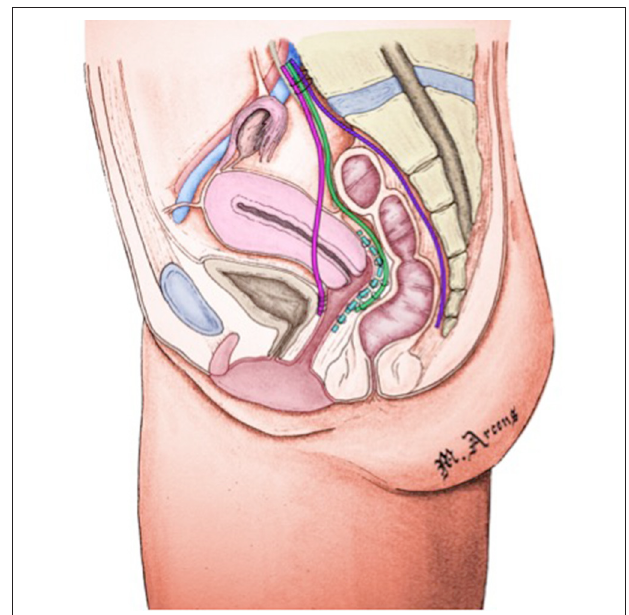
FIGURE 1 | Surgical procedure. Image copyright: Marc Arcens, used with permission.